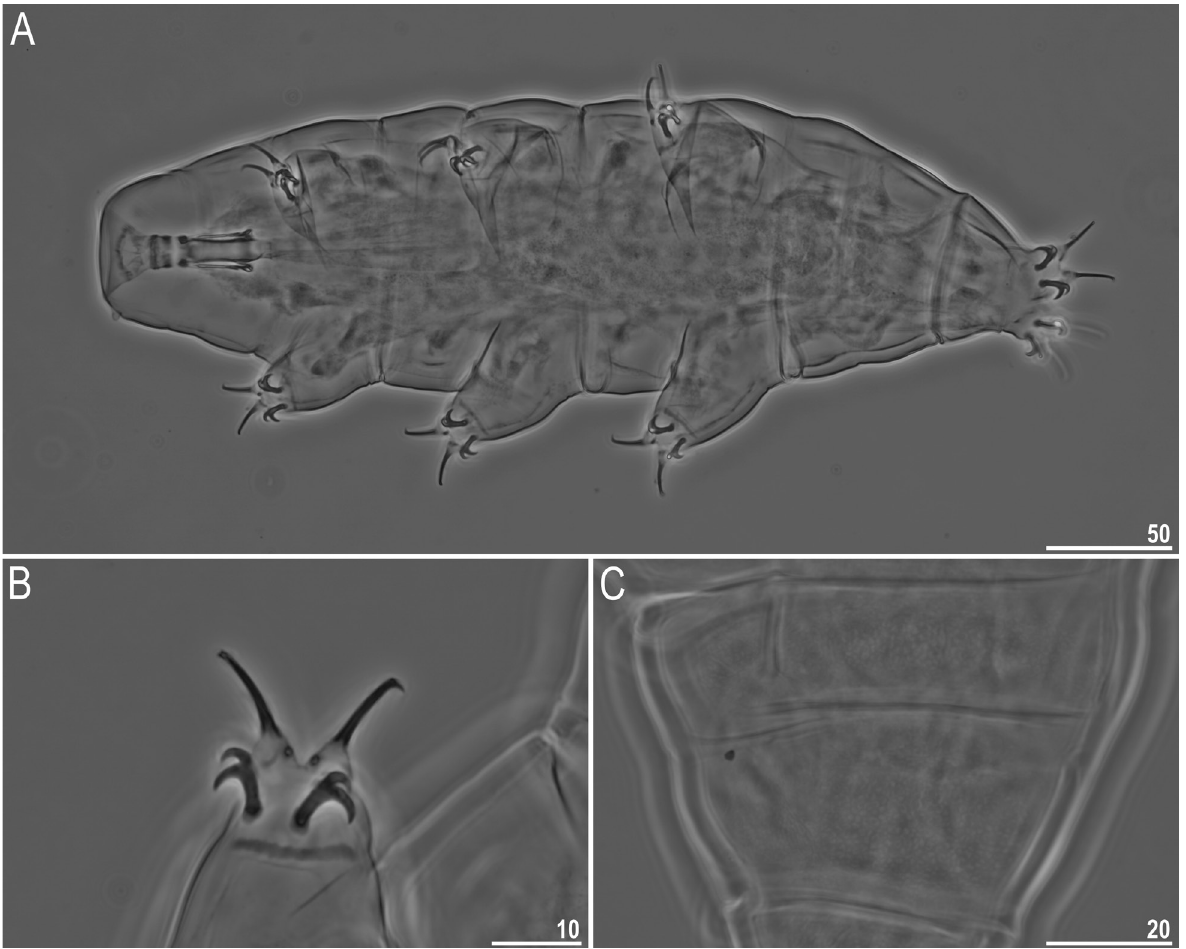
Figure 1. The morphology of Milnesium almatyense Tumanov, 2006 hatchlings, PCM. A Habitus; B Claws II, with the [2-2] CC; C Dorsal cuticle with visible sculpture in form of reticulation. All the scale bars are given in